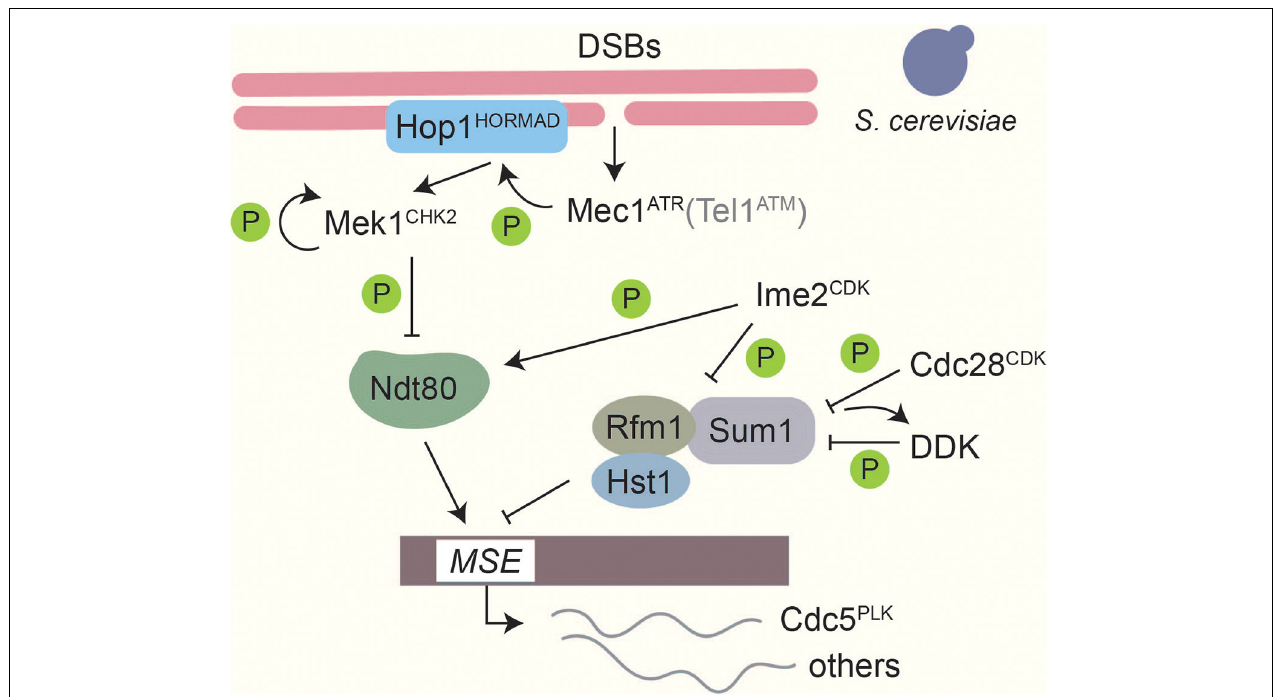
FIGURE 4 | Phosphorylation-based regulation of middle gene transcription in Saccharomyces cerevisiae . Transcriptional control of middle genes in S. cerevisiae is under the control of several kinases. Formation of DSBs activates Mec1 ATR , which in turn activates Mek1 CHK 2 through Hop1 phosphorylation and Mek1 CHK 2 autophosphorylation. Tel1 ATM contributes only weakly (Carballo et al., 2008). Ndt80 binding to middle sporulation elements (MSEs) is downregulated by Mek1 CHK 2 phosphorylation (Chen et al., 2018). Thus, when DSBs are present expression of middle sporulation genes is blocked. On the other hand, Ime2 CDK -dependent phosphorylation promotes Ndt80 activity and facilitates competition with the Sum1 transcriptional repressor complex on MSEs (Sopko et al., 2002; Benjamin et al., 2003). Ime2 CDK , along with Cdc28 CDK and Cdc7 DDK , also phosphorylates Sum1 to promote dissociation of the repressor complex from MSEs (Lo et al., 2008; Sasanuma et al., 2008; Ahmed et al., 2009; Corbi et al.,